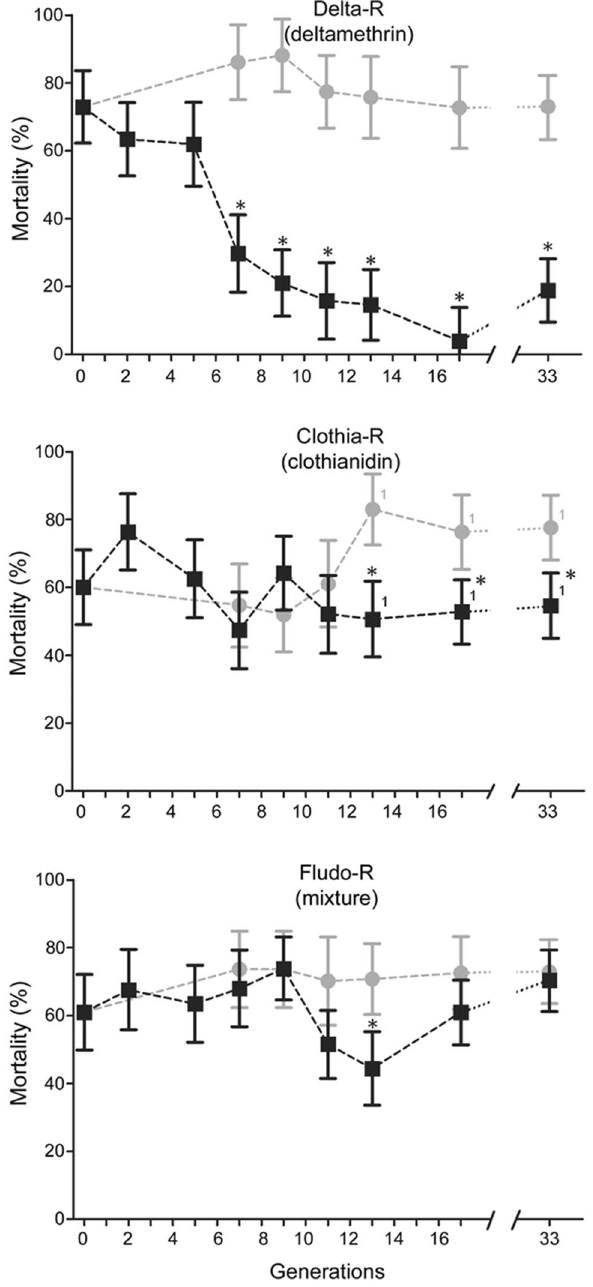
Figure 1. Resistance dynamics of each line along the selection process. Black squares: resistance of each selected line to the insecticide used for selection. Grey dots: resistance of the non-selected Tiassalé-S line. Resistance levels were compared using bottle assays and are expressed as mean % mortality ± 95% Wald confidence interval. Comparisons between each line and the Tiassalé-S line at each time point were performed using a Fisher test on mortality proportions (*p < 0.05). 1 Indicate that a new clothianidin solution was used for monitoring resistance levels at G13, G17 and G33, leading to higher clothianidin mortality rates as compared to previous